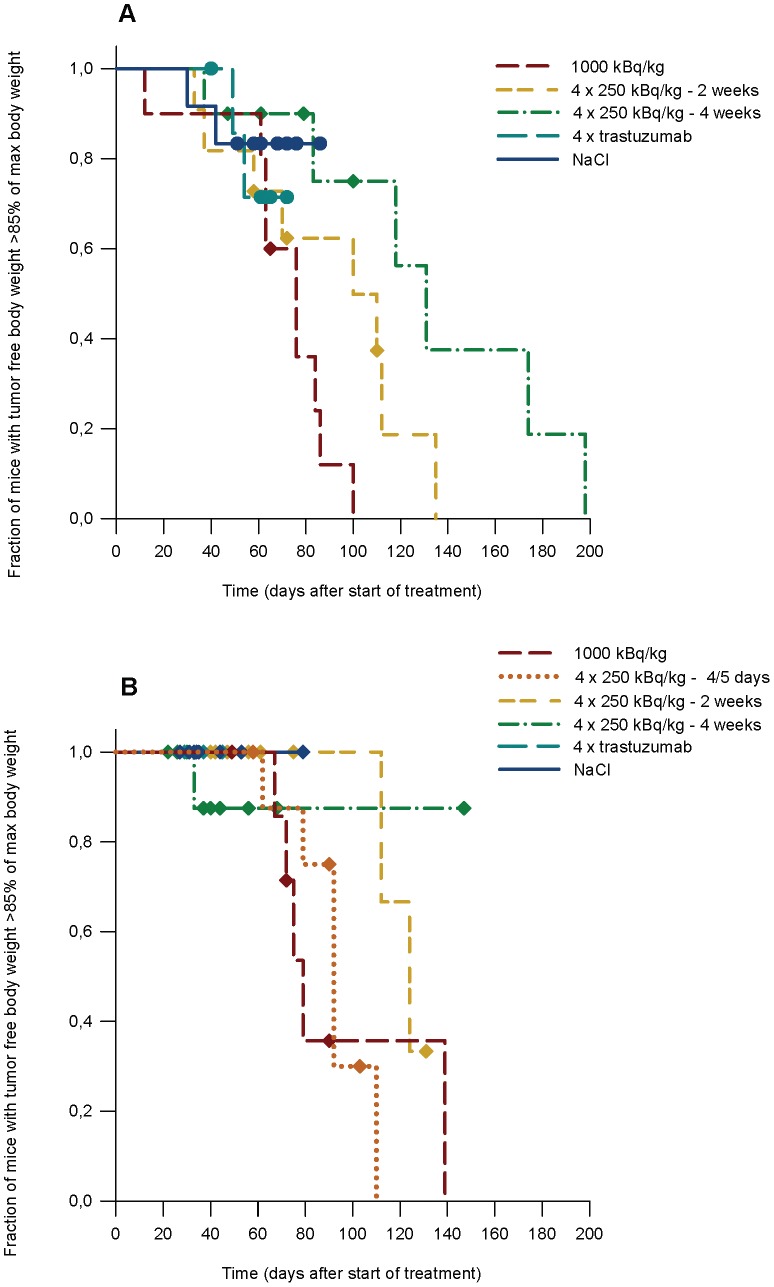
Survival without substantial loss of body weight.Survival of mice carrying SKOV-3 (A) and SKBR-3 (B) tumor xenografts as function of days after onset of therapy. The survival end point was loss of more than 15% of maximum body weight. Mice euthanized due to other reason than loss of weight were censored in each plot.